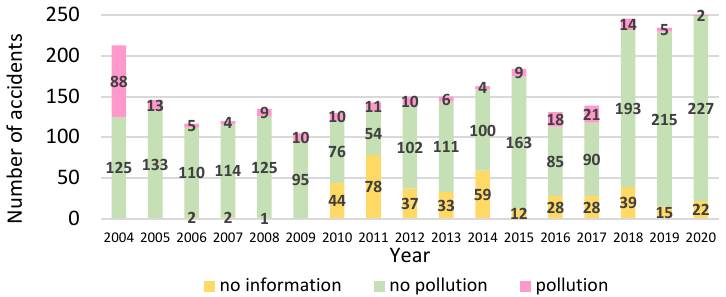
Figure 7. Number of reported accidents in the Baltic Sea in years 2004–2020 [82–85].